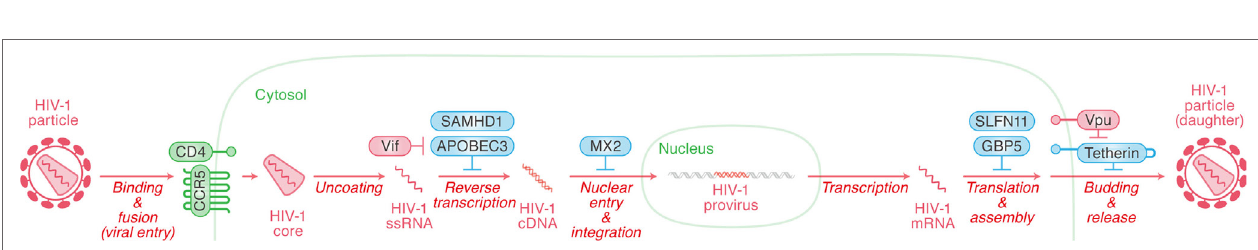
FiGURe 3 | Restriction factors (RFs) controlling human immunodeficiency virus type 1 (HIV-1) replication and viral antagonists. Viral replication steps are indicated in red (in italic) with arrows. The RFs inhibiting viral replication at respective step are indicated in cyan, while the viral accessory proteins counteracting the action of certain RFs are indicated in red. Cellular organelle and viral components are indicated in green and red, respectively. The detail of each step is described in the main